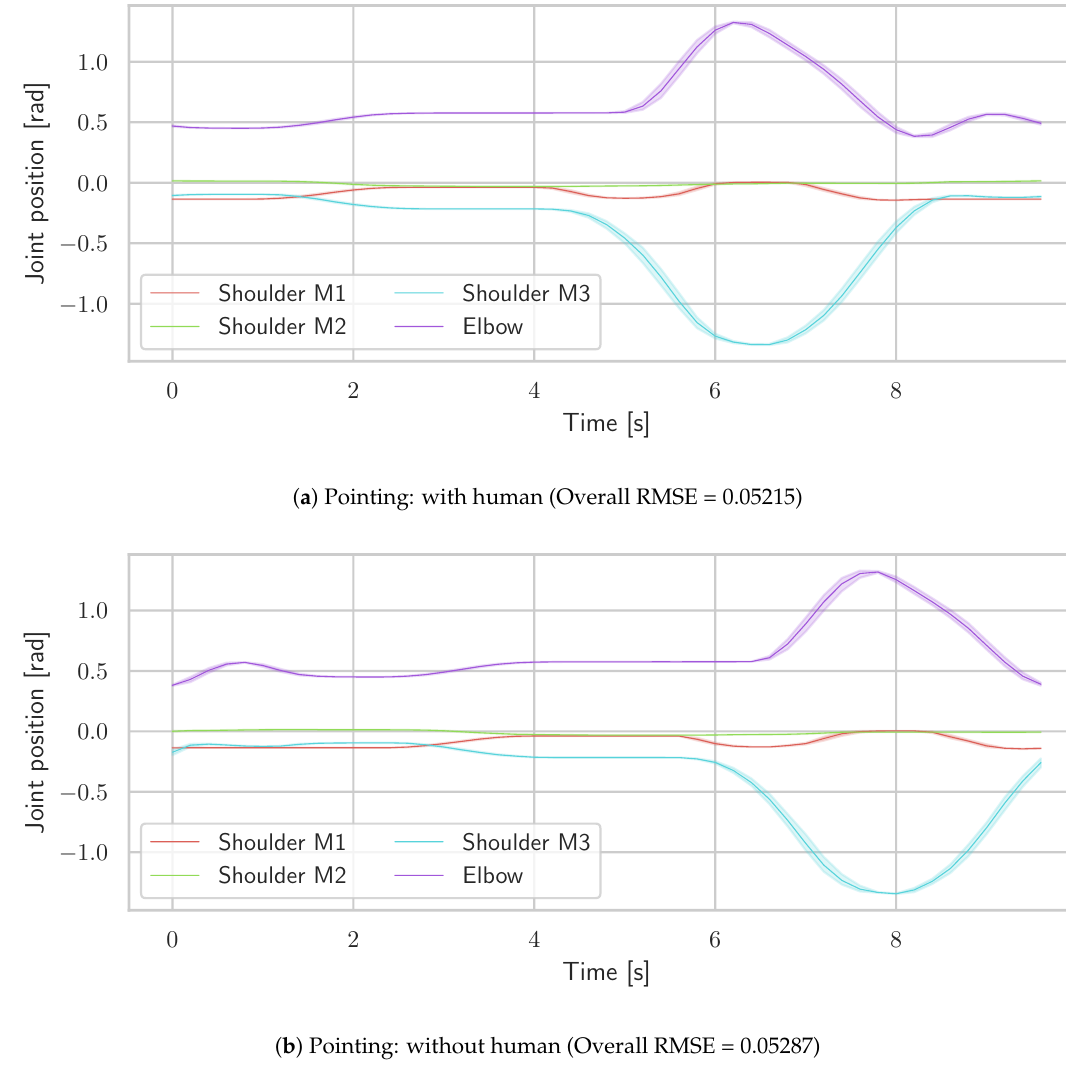
Figure 15. Teach & Replay therapy for pointing movement.